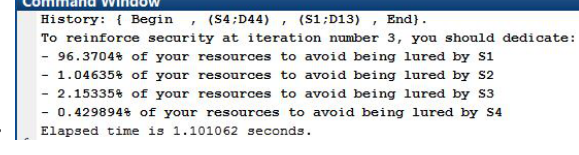
Figure 6. Case N o 1: recommendations